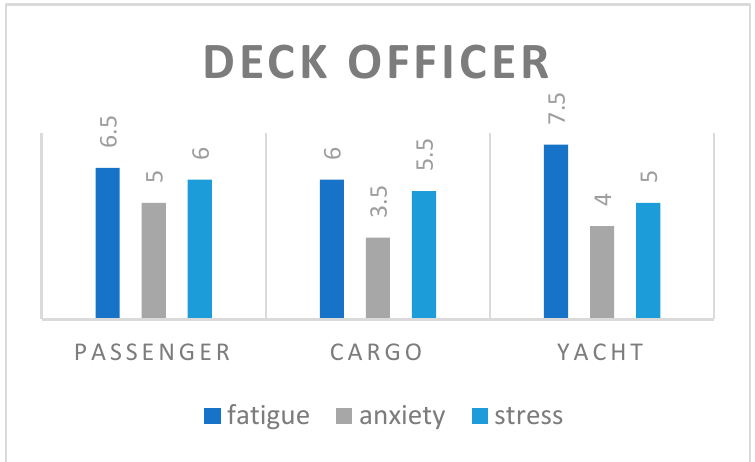
Figure 3. Rates of fatigue, anxiety and stress among deck officers on various types of vessels .